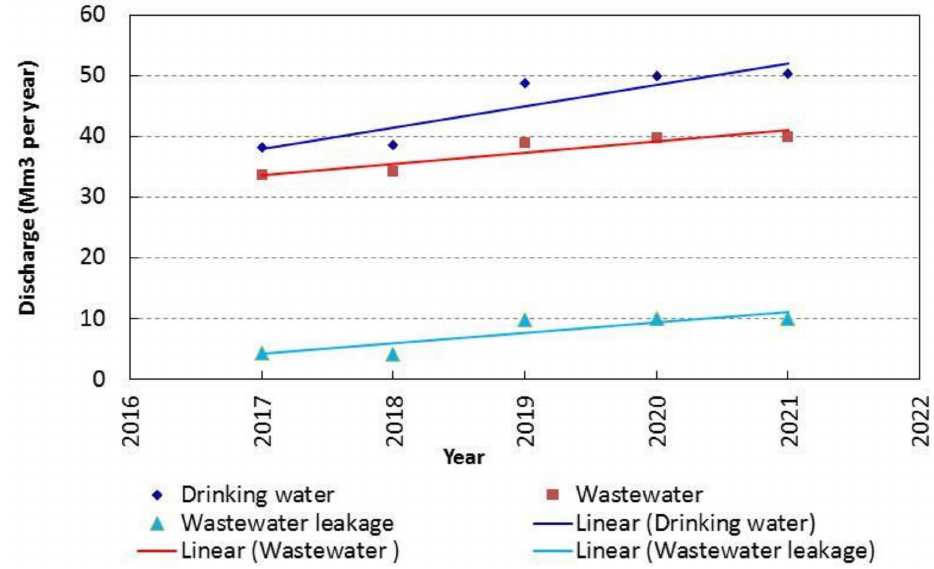
Figure 10. The amounts of drinking water and sanitation in the city of